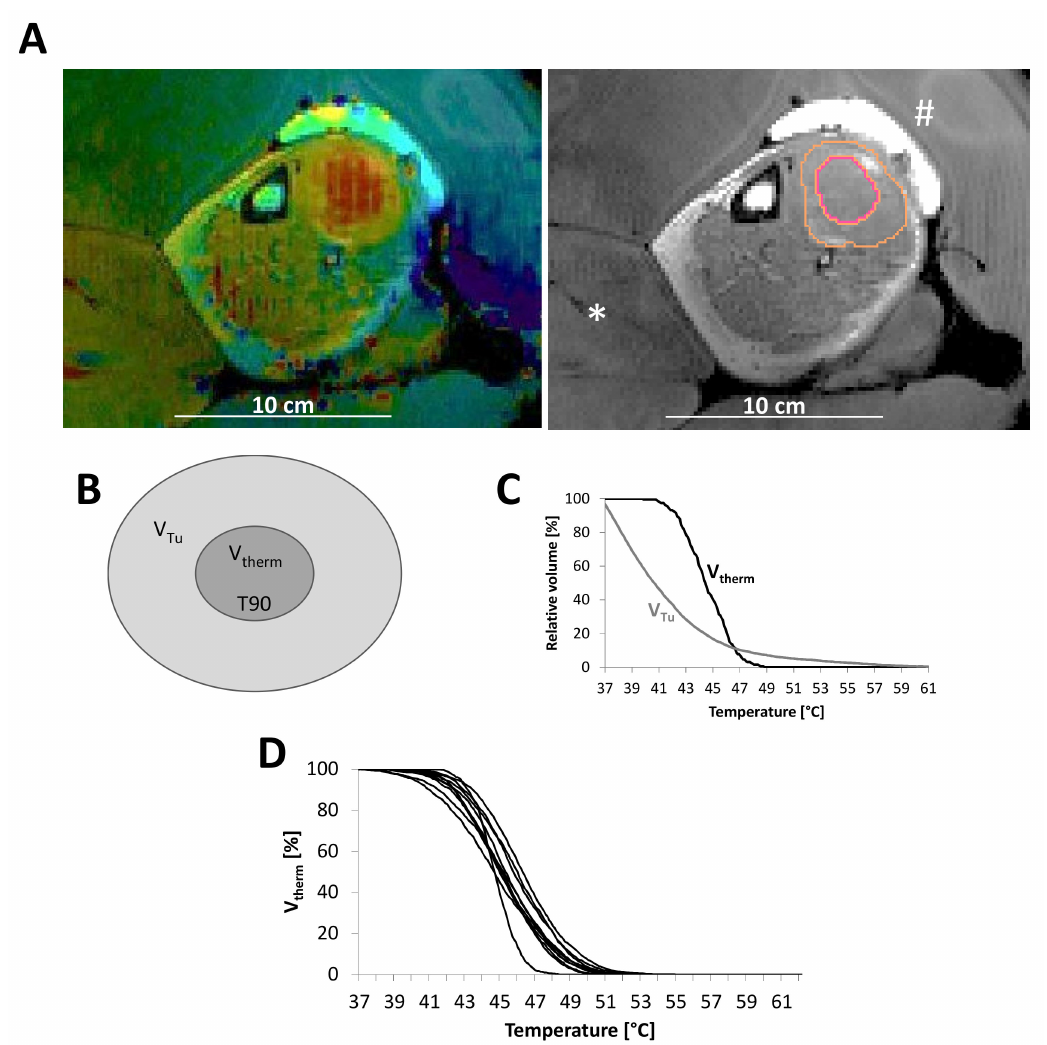
Figure 2. An example of a sarcoma of the calf shows the use of water bags (*) between the legs, as well as oil bags (#) to enhance the temperature in the tumor close to the skin surface. The outer contour (orange) depicts the tumor volume, the inner contour (red) indicates the volume used for thermometry (V therm ) ( A ) as also indicated in the schematic view ( B ). Comparing temperature-volume histograms for the whole tumor volume (V Tu ) versus V therm show a more reliable temperature distribution for V therm ( C ). Temperature-volume histograms for all treatments of one patient show a quite consistent temperature distribution and small intrapatient variability ( D